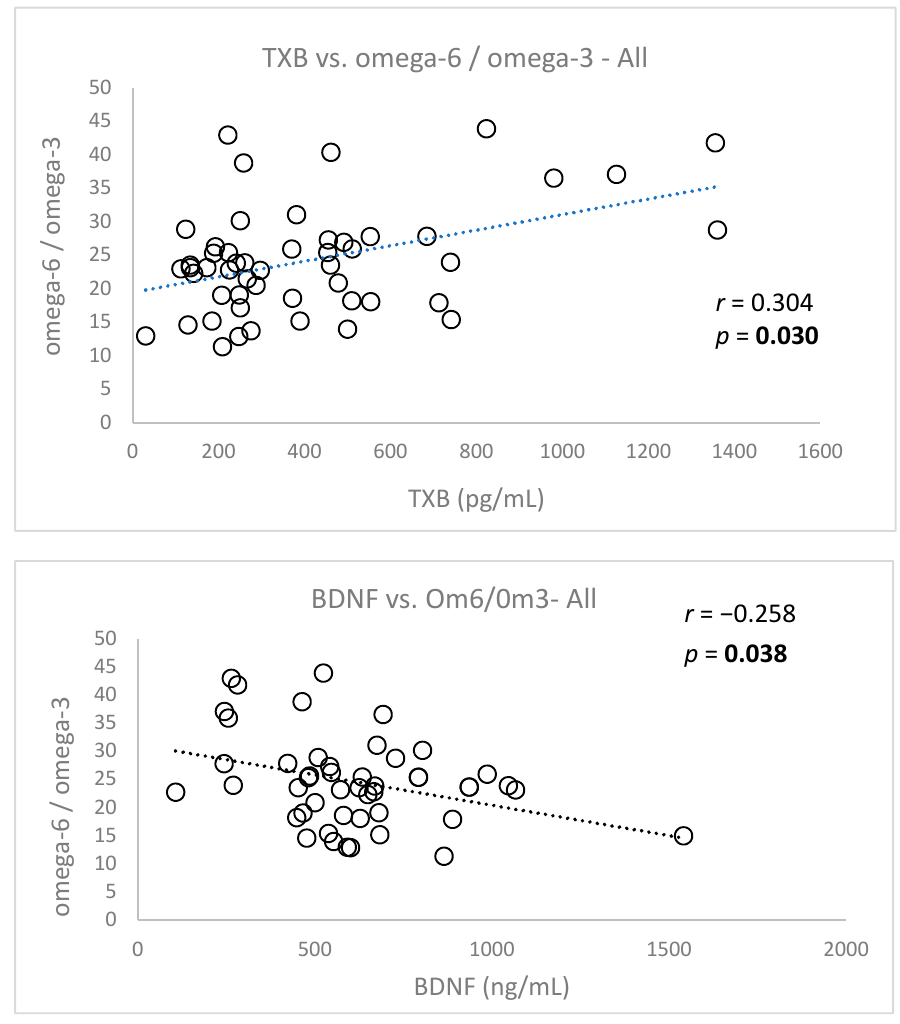
Figure 4. Correlations of basal TXB and BDNF values with omega-6/omega-3 ratio in patients with DD. TXB = thromboxane, BDNF = brain-derived neurotrophic factor, r = Spearman’s rank correlation coefficient, p = statistical significance. Table 4. Correlations between parameters in patients and controls at baseline.